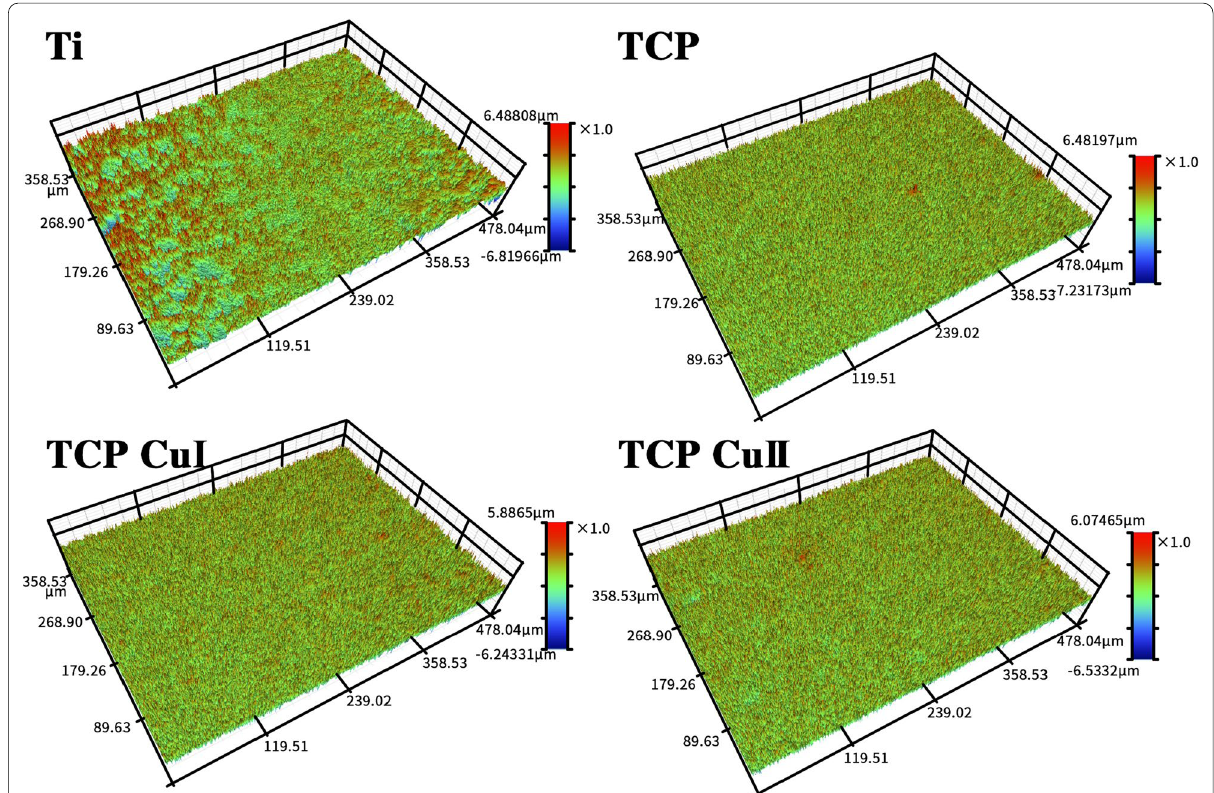
Fig. 5 Profilometer morphology of different